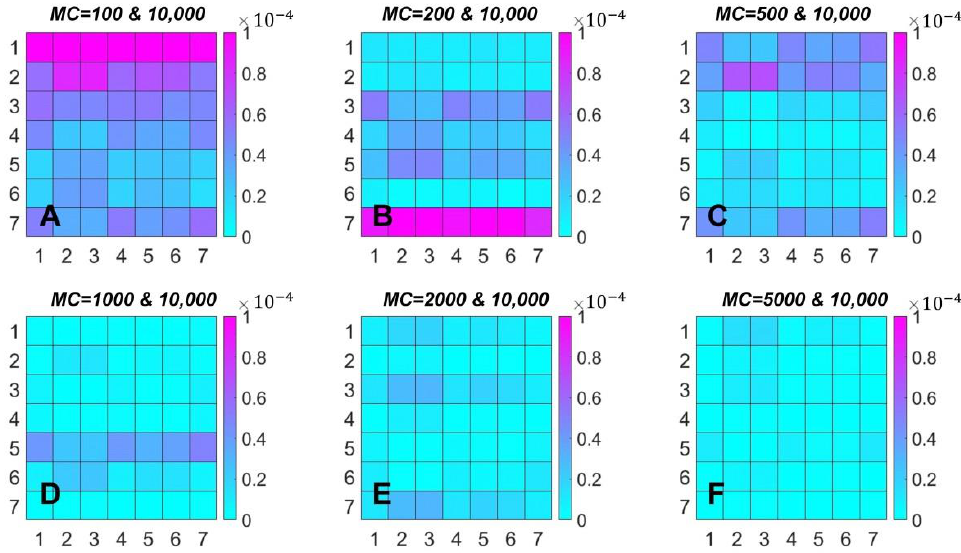
Figure 3. The same data as in Figure 2. Demonstration of the differences between spectra calculated at MC = 10,000 and the other six values of MC. X-axis of each matrix corresponds to seven spectra with MC = 10,000, Y-axis enumerates spectra for MC = 100 ( A ), 200 ( B ), 500 ( C ), 1000 ( D ), 2000 ( E ), and 5000 ( F ). Color bars reflect the variations of 𝜒 2 .